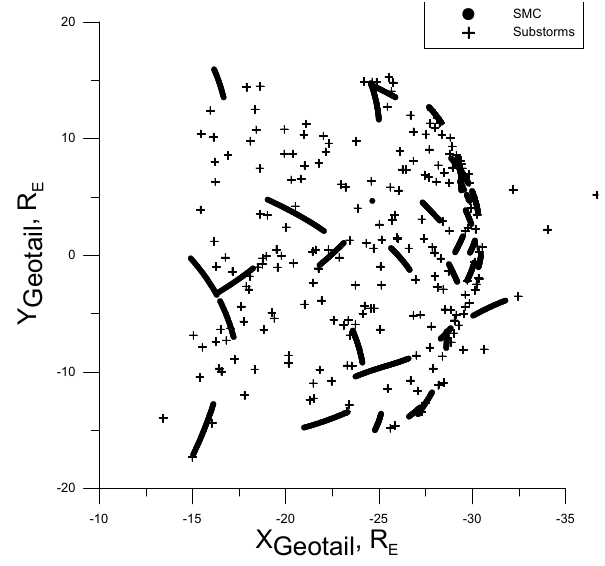
Fig. 1. Geotail position in GSM coordinates during SMCs (circles) and substorms onsets (crosses).